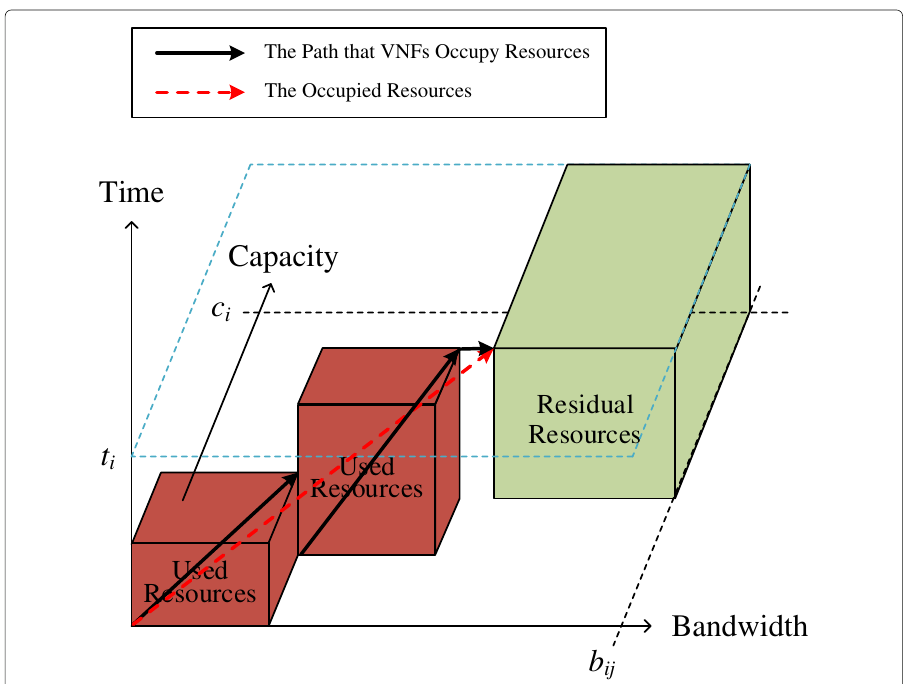
Fig. 3 The bin. This is the bin which each MEC server is regarded. In this architecture, we denote its storage, virtual link bandwidth requirements, and usage time as a three-dimensional vector